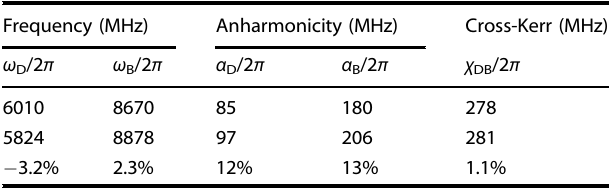
Table 3. Two-qubit, one-waveguide